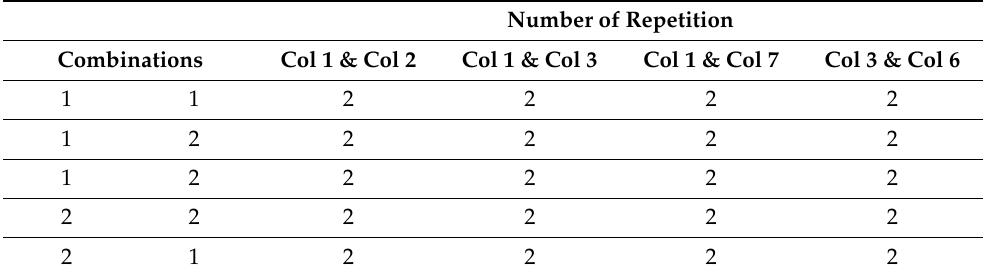
Table 2. The number of repetitions of level